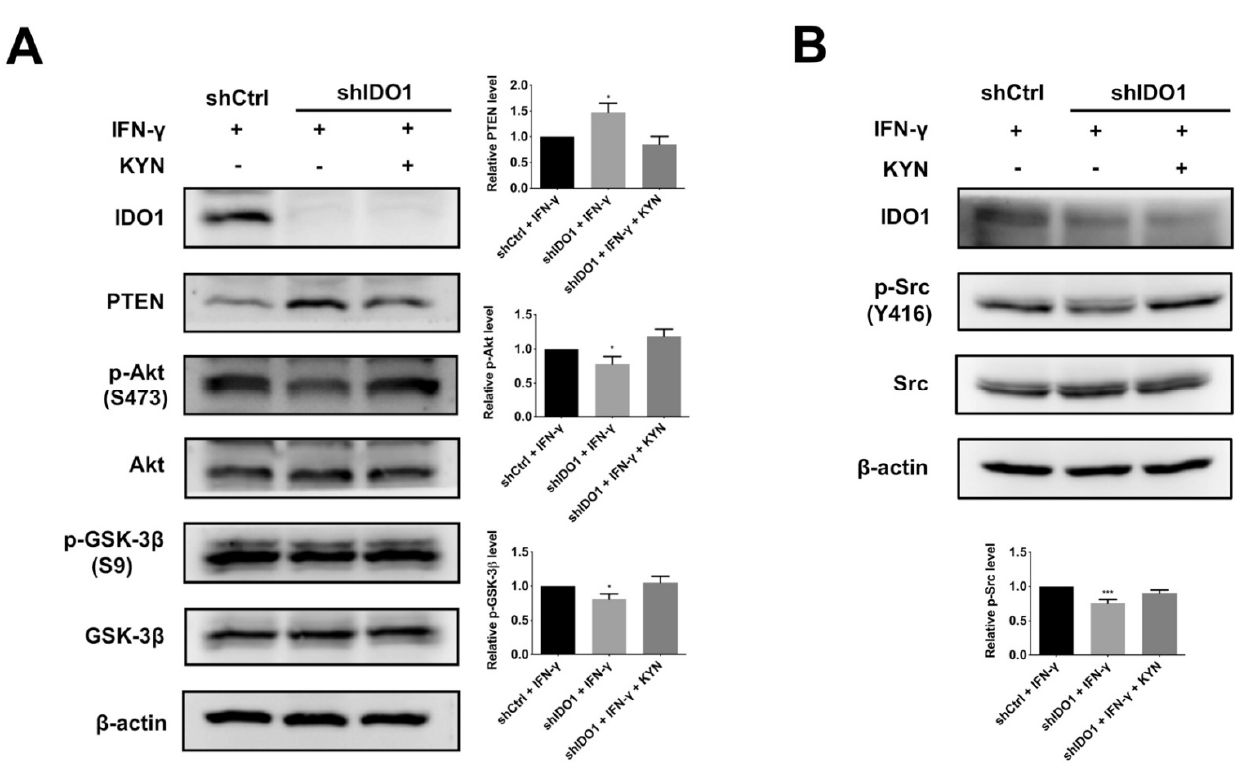
Figure 4. AhR-mediated Src-PTEN-Akt-GSK-3 β pathway activation promotes β -catenin activity under IDO1 upregulation. ( A ) Sequential induction of IDO1 and AhR activity inhibited GSK-3 β via PTEN suppression and Akt activation. The expression of PTEN was downregulated while the phosphorylation of Akt (S473) and GSK-3 β (S9) was upregulated by IFN- γ induction in shCtrl cells or by KYN rescue in shIDO1 cells. Left, shCtrl and shIDO1 HuH-7 cells were induced by IFN- γ (40 ng/mL) with or without KYN (100 µ M) rescue. Cell lysates were separated via SDS-PAGE and analyzed via immunoblotting with the specified antibodies. Right, quantitative analysis of alterations in expression levels of PTEN, p-Akt (S473) and p-GSK-3 β (S9). ( B ) Promotion of Src activity under IDO1 upregulation and subsequent AhR activation. The phosphorylation of Src (Y416) was significantly increased in shCtrl cells by IFN- γ induction compared to shIDO1 cells. KYN rescue of shIDO1 cells restored the upregulation of p-Src (Y416). Upper, control and IDO1 knockdown HuH-7 cells were stimulated by IFN- γ (40 ng/mL) with or without KYN (100 µ M) rescue. Cell lysates were separated via SDS-PAGE and subjected to immunoblot analysis. Lower, quantification of changes in phosphorylation of Src. Band intensities were quantified via densitometry and normalized to β -actin from three independent replicates (shCtrl, control shRNA; shIDO1, shRNA against IDO1; *, p < 0.05; ***, p <